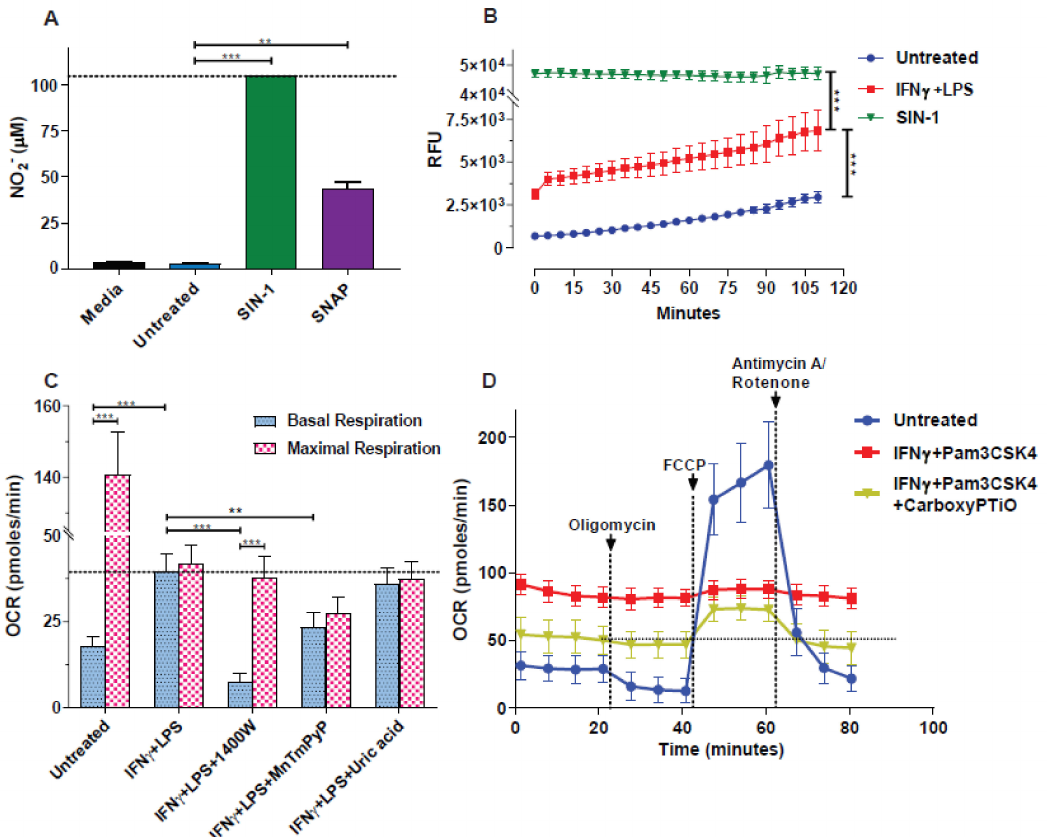
Figure 2. Quantification of macrophage- or donor-derived NO • , and the partial cell-respiration rescue by NO • and O 2 •− blockade. ( A , B ) Macrophages were activated for 24 h with IFN γ (40 ng/mL) plus LPS (10 ng/mL) or not (untreated) and cell supernatants were analyzed for ( A ) nitrites (NO 2 ¯ ), using the Griess assay. NO 2 ¯ levels were expressed as µ M using serial dilutions of NaNO 2 for the standard curve. Cell-free media, similar to the one used for background subtraction in Seahorse served as an additional control. ( B ) For the DAF-FM assay, serial fluorescent measurements of active NO • were taken every 5 min in a Seahorse mirror plate. Values in media from cell-free wells (blank), were subtracted. ( A , B ) In both cases the reactive species-donors SNAP (3 mM) and/or SIN-1 (3 mM) were added to cell-free wells prior to the respective assays. The Kruskal-Wallis test (with the Benjamini-Krieger-Yekutieli two-stage linear step-up, or with the Dunn’s, procedure) was used for comparisons. ** p < 0.01, *** p < 0.001. ( C , D ) The ROS/RNS inhibitors/scavengers 1400 W (50 µ M), MnTmPyP (15 µ M), uric acid (250 µ M) or carboxyPTiO (100 µ M) were used as indicated to treat macrophages for 1 h prior to activation with ( C ) IFN γ + LPS (40 ng/mL and 10 ng/mL respectively) or ( D ) IFN γ + Pam3CSK4 (40 ng/mL